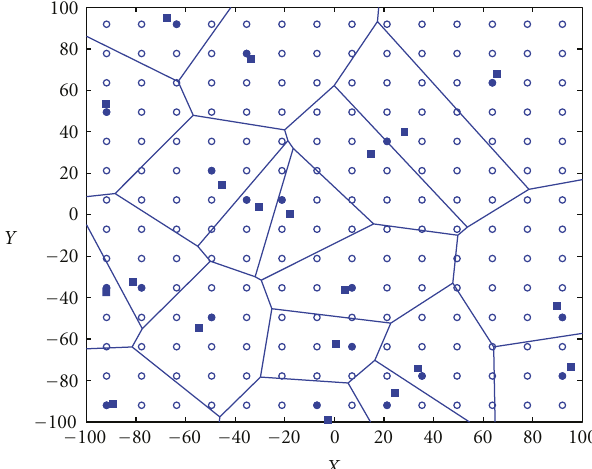
Figure 4: Voronoi polygons for each static node: Solid square-static node locations, solid circles-grid points (centers) corresponding to static nodes and void circles-grid points (centers) corresponding to grids not covered by static